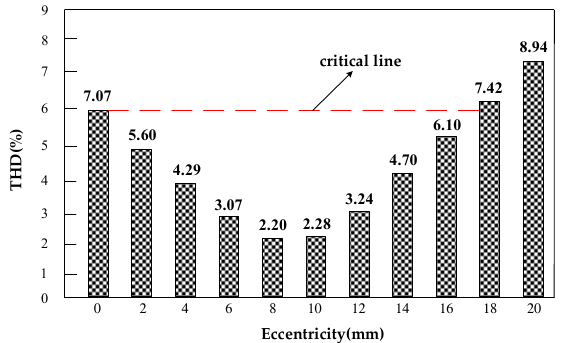
Figure 12. The total harmonic distortion under different eccentricity.